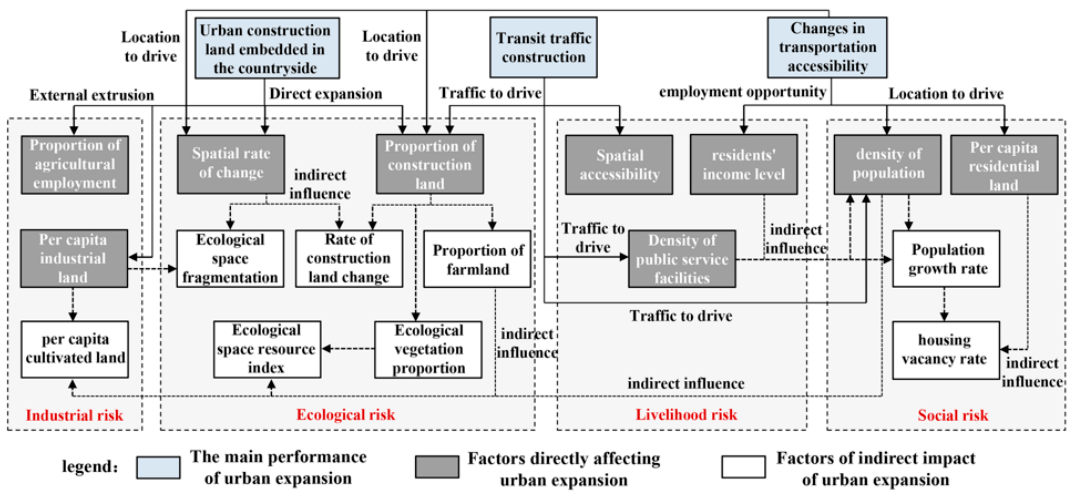
Figure 12. The influence mechanism of urban expansion on the suburban rural systemic risk factors (source: